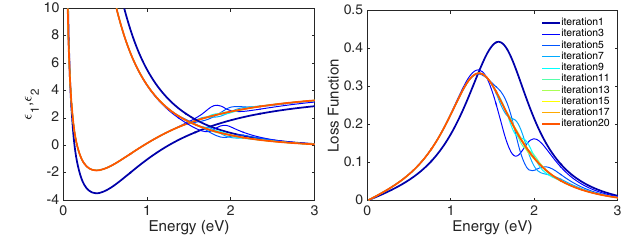
FIG. 17. Example of the c -axis correction obtained in 20 iterations: dielectric function (left panel) and corresponding loss function (right panel).